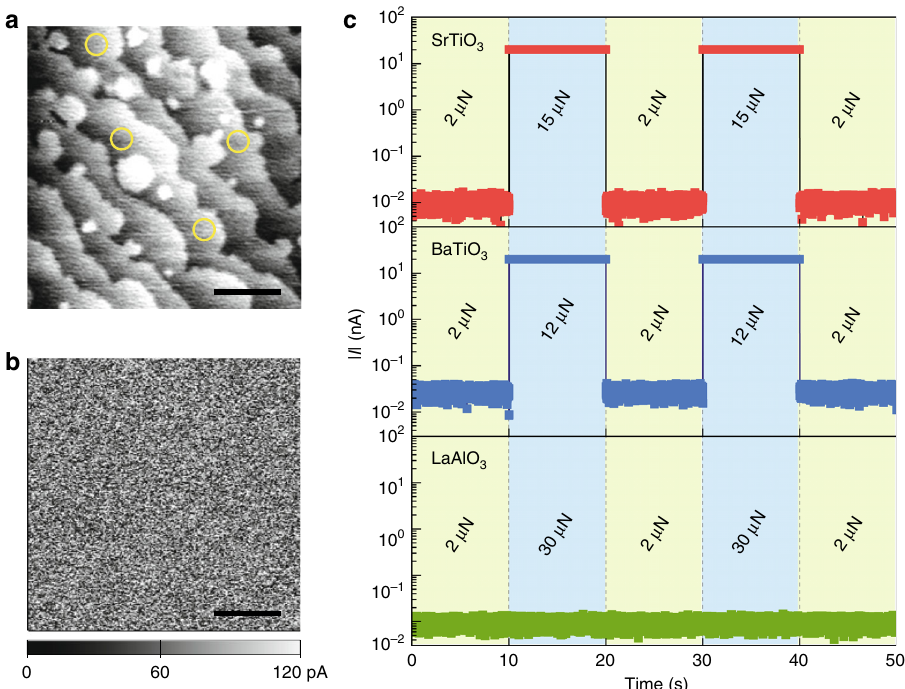
Fig. 4 Reversible fl exoresistance effect. a Topographical image obtained after the experiment. Regions where the experiments were conducted are marked by yellow circles. b Current mapping image on the same area, recorded with a 1-V bias voltage under a constant tip ’ s loading force of 2 μ N, indicating that no current hotspot has been made after the experiment. c Current measured with a 0.1-V bias voltage under two representative loading forces in STO (red symbols), BaTiO 3 (blue symbols) and LaAlO 3 (green symbols). The lower threshold loading force (i.e., around 12 μ N) for BaTiO 3 may originate from inherently stronger fl exocoupling strength in BaTiO 3 (ref. 29 ), compared with that in STO. During the measurements, we set the current limit (compliance) to 20 nA. Scale bars in ( a ) and ( b ) represent 2 μ m. Source data are provided as a Source data fi